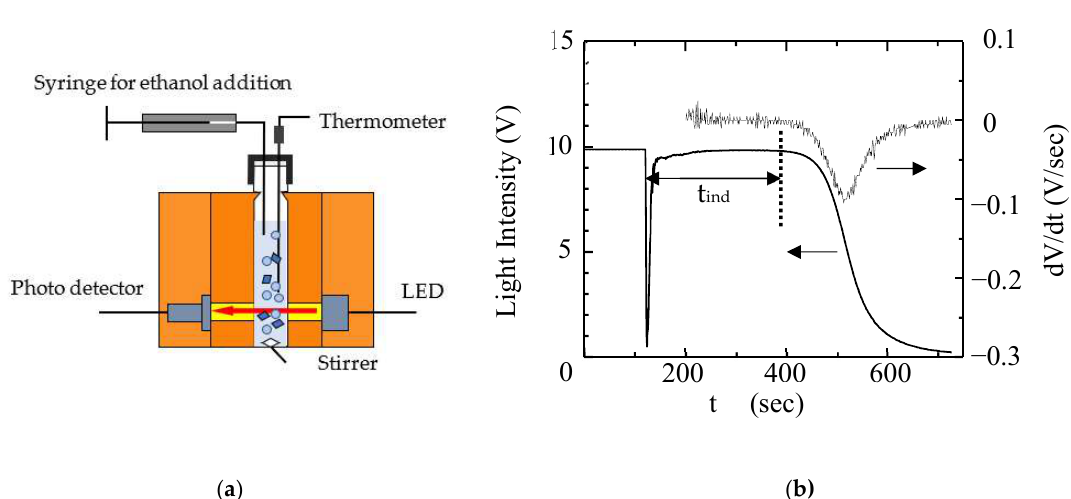
Figure 2. ( a ) Apparatus to measure the induction time; ( b ) Light intensity change to determine induction period (t ind ) in the poor solvent crystallization.